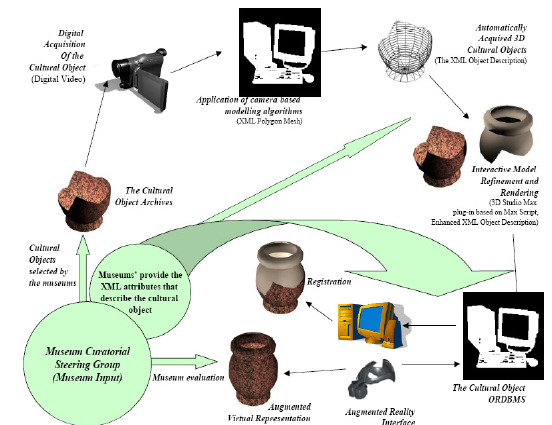
Figure 2. The overall architecture of ARCO (Mourkoussis et al, 2002).